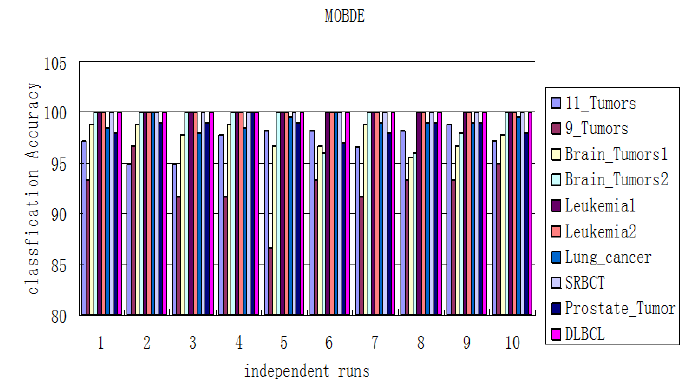
Figure 2. The accuracy obtained by MOBDE in each independent run.